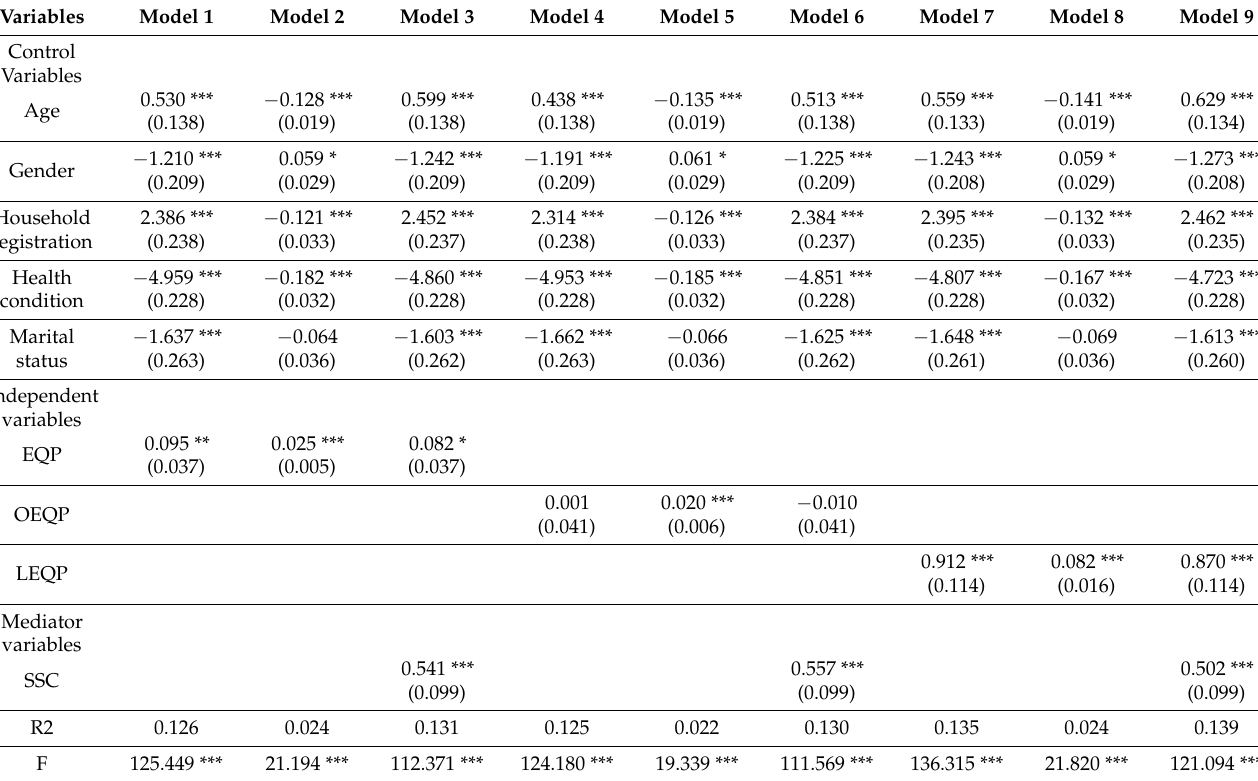
Table 3. Test results of mediating